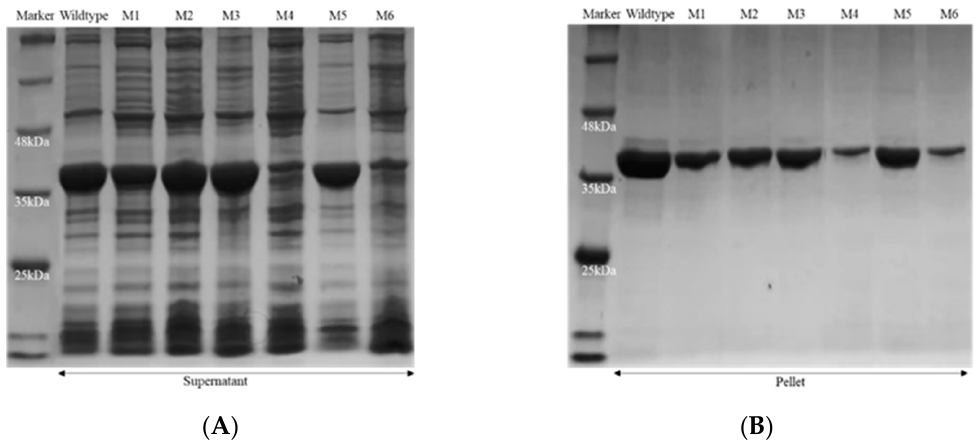
Figure 3. SDS-PAGE of the Ml ADH (35.8 kD with a 6×His tag) and its mutant expression in E. coli BL-21(DE3). ( A ) Supernatant; ( B ) Pellet. Mutants of M1 to M6 was D37G, D37G-V39S, D37G-A38T-V39K, Y36S-D37G-A38D, Y36S-D37G-A38G-V39K, and Y36S-D37G-A38D-V39K, respectively.